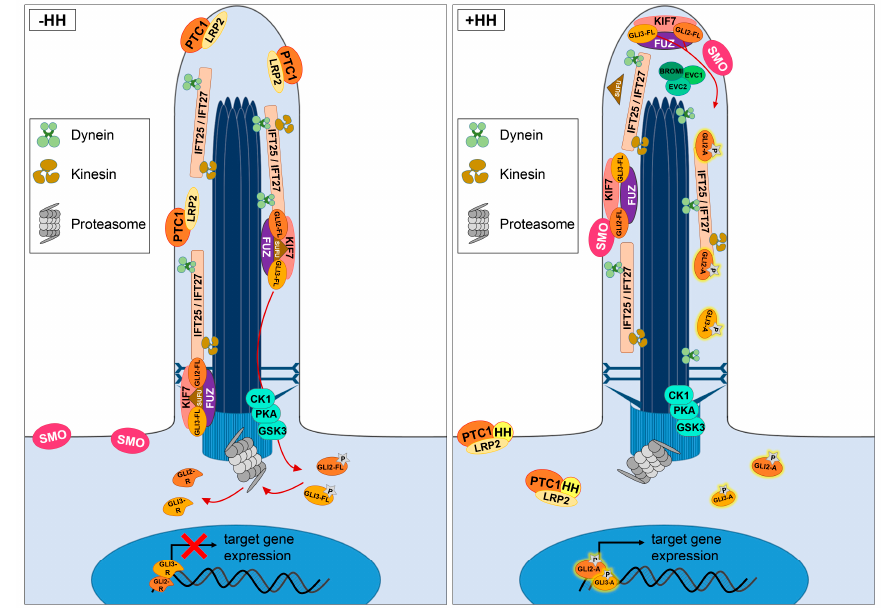
Figure 2. Hedgehog signalling at primary